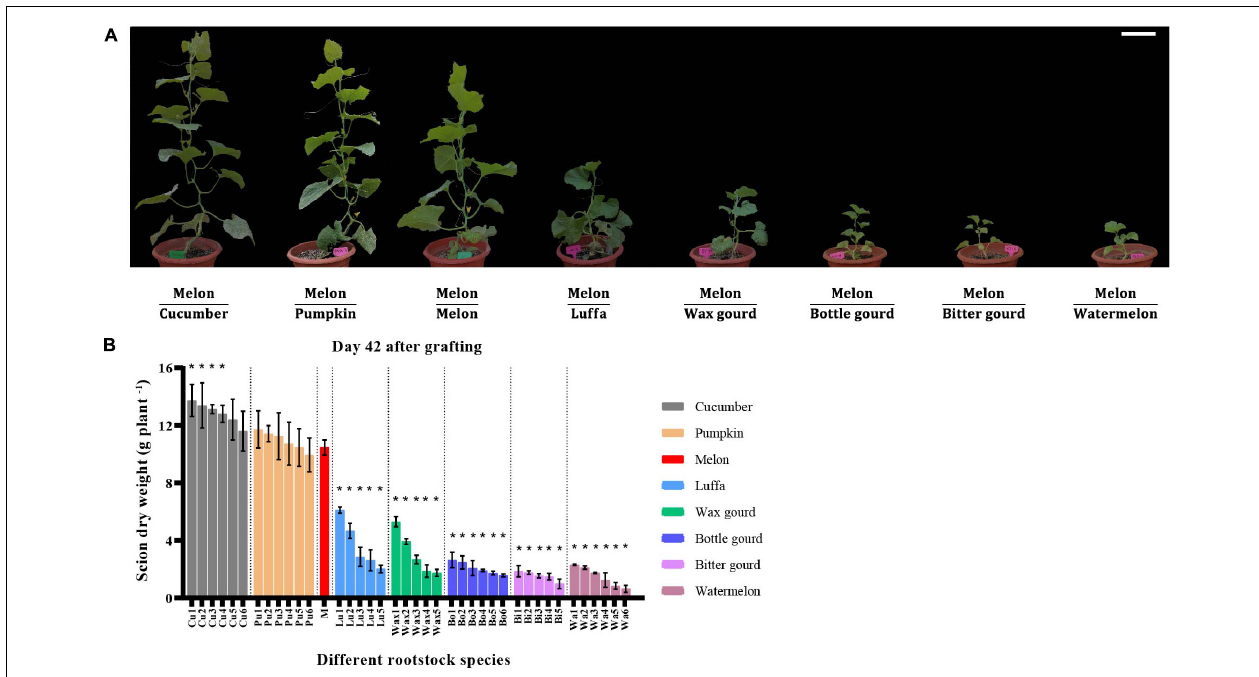
FIGURE 1 | Pictures and scion dry weight of melon grafted onto eight Cucurbitaceae species. (A) Pictures of melon cv. ‘Akekekouqi’ grafted onto cucumber cv. ‘Jinyou No.35,’ pumpkin cv. ‘Qingyouzhen No.1,’ melon cv. ‘Akekekouqi,’ luffa cv. ‘Sanbi No.6,’ wax gourd cv. ‘Aonong,’ bottle gourd cv. ‘H19,’ bitter gourd cv. ‘Liangku No.1,’ and watermelon cv. ‘Zaojia 8424’ on day 42 after grafting. Scale bar represents 15 cm. (B) Scion dry weight of melon cv. ‘Akekekouqi’ grafted onto cucumber (Cu1–Cu6), pumpkin (Pu1–Pu6), melon (M), luffa (Lu1–Lu5), wax gourd (Wax1–Wax5), bottle gourd (Bo1–Bo6), bitter gourd (Bi1–Bi5), and watermelon (Wa1–Wa6) on day 42 after grafting. Asterisks indicate a significant difference between melon homo-grafted plants and hetero-grafted plants on day 42 after grafting using Student’s t -test ( p <